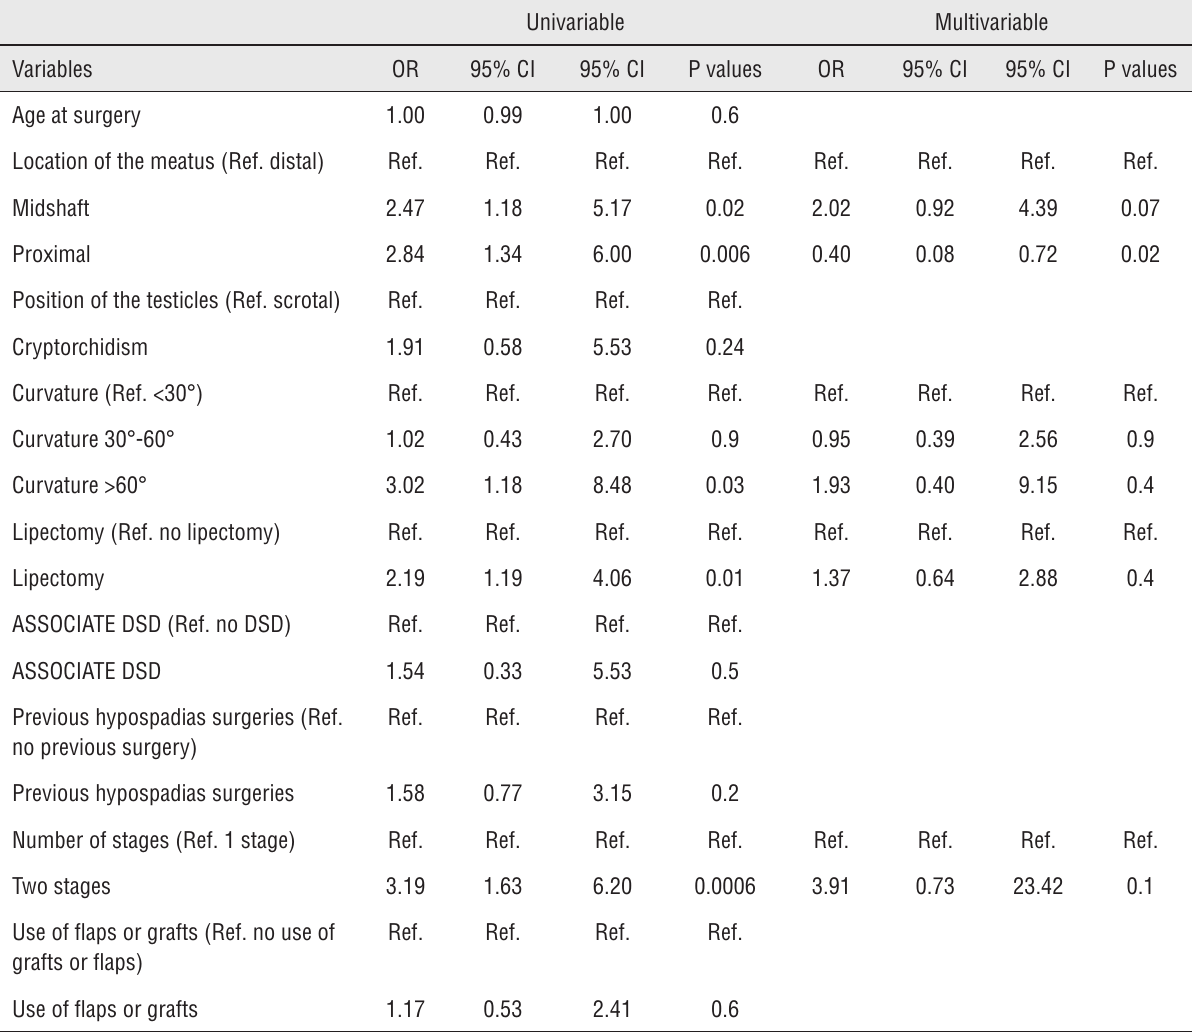
Table 4 - Univariable and multivariable logistic regression models testing for any complications in patients treated with or without pubic lipectomy, within 266 patients treated for hypospadias. Univariable